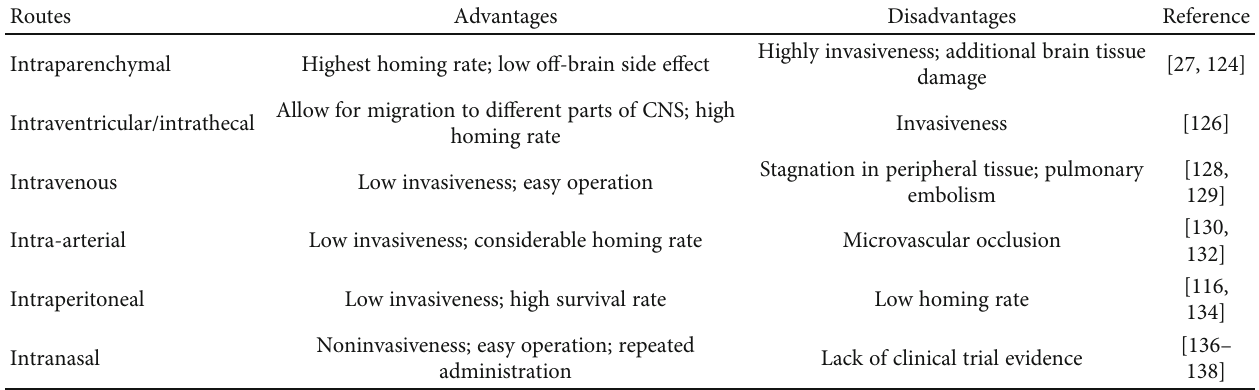
Table 1: Advantages and disadvantages of di ff erent MSC transplant